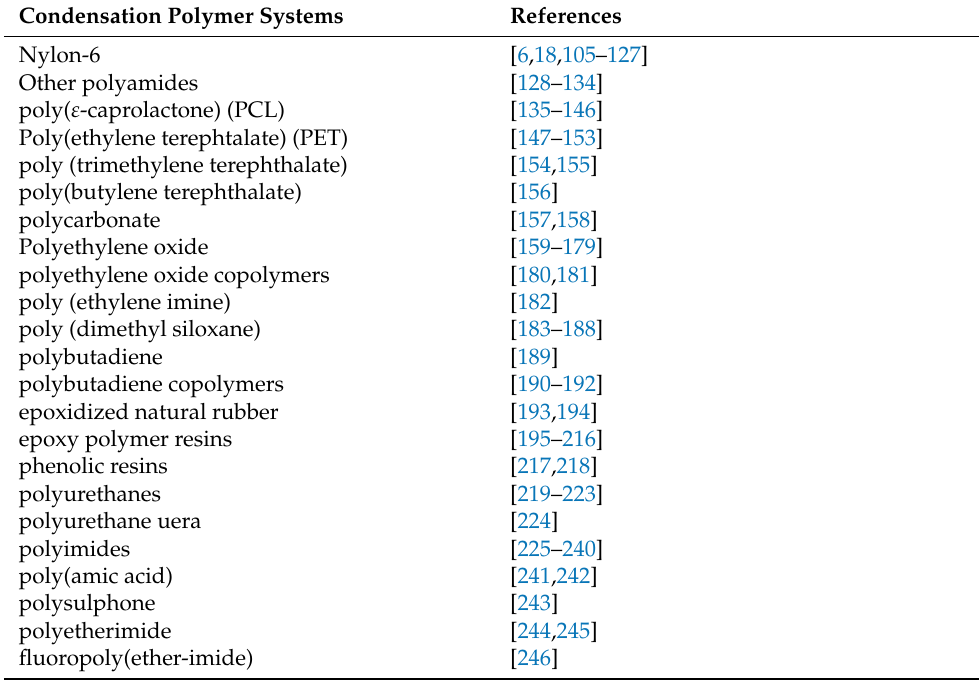
Table 3. Condensation polymers and rubbers classification.